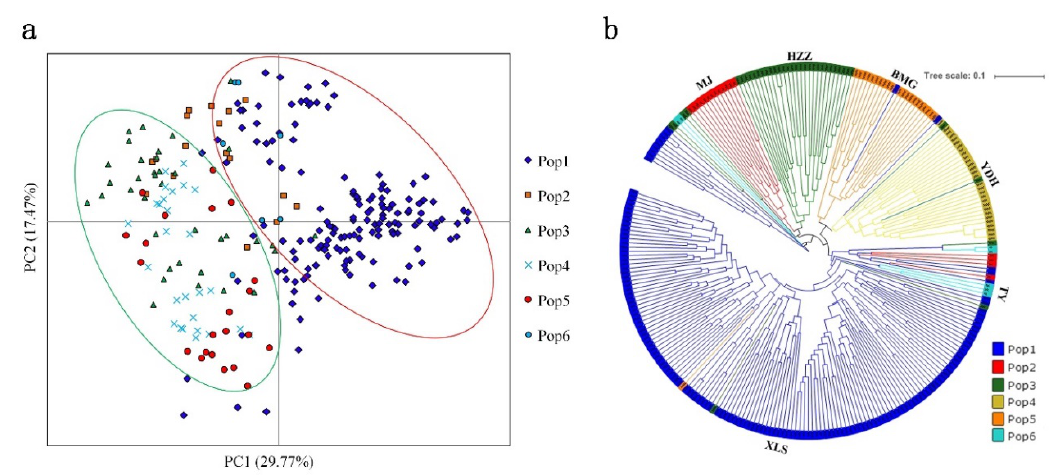
Figure 5. Graphical representation of differentiation between populations. ( a ) Principal component analyses (PCA). ( b ) UPGMA tree of 261 A. miaotaiense individuals.